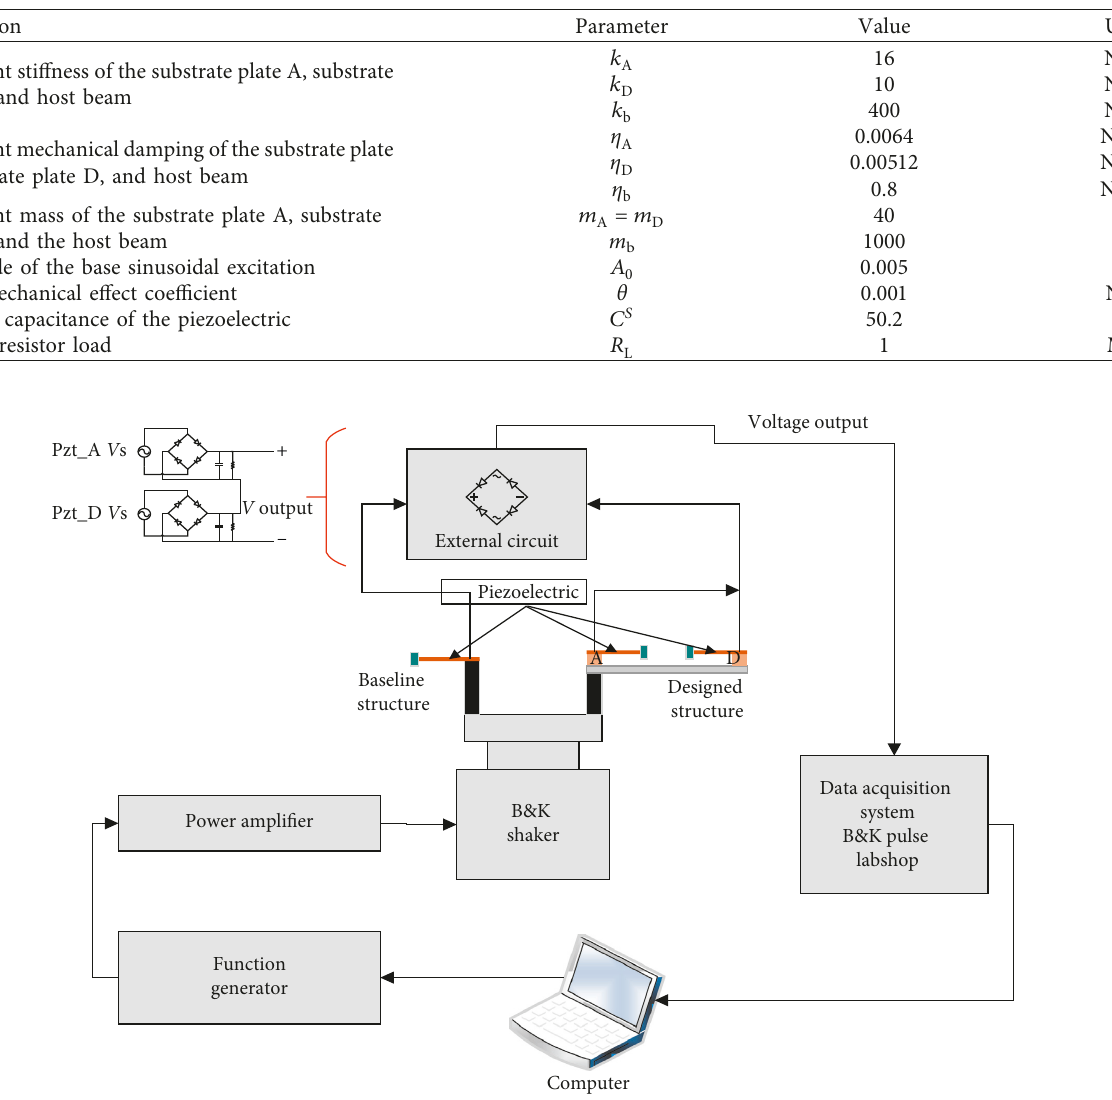
Figure 5: Schematic of the experimental